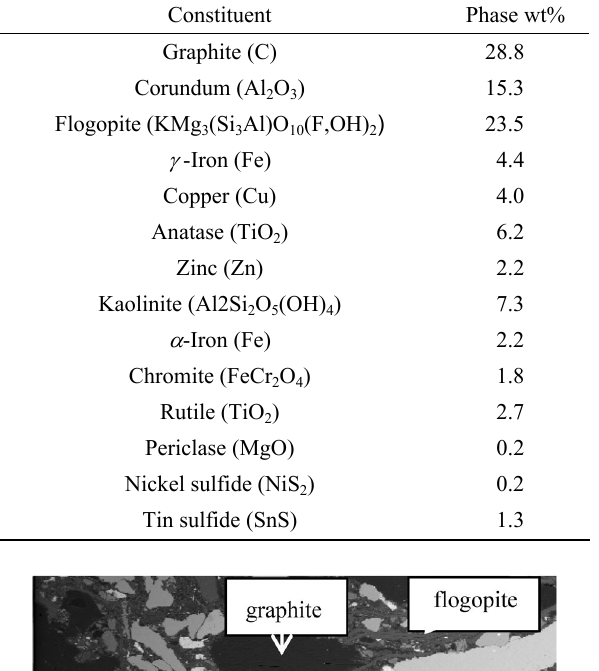
Table 1 Phase composition of the FM4 pad material, as evaluated from XRD data (see main text for details on the experimental method). The concentrations of phenolic resin and of the other organic components are not included. Typical contributions of these components sum up to 7 wt%–10 wt%.